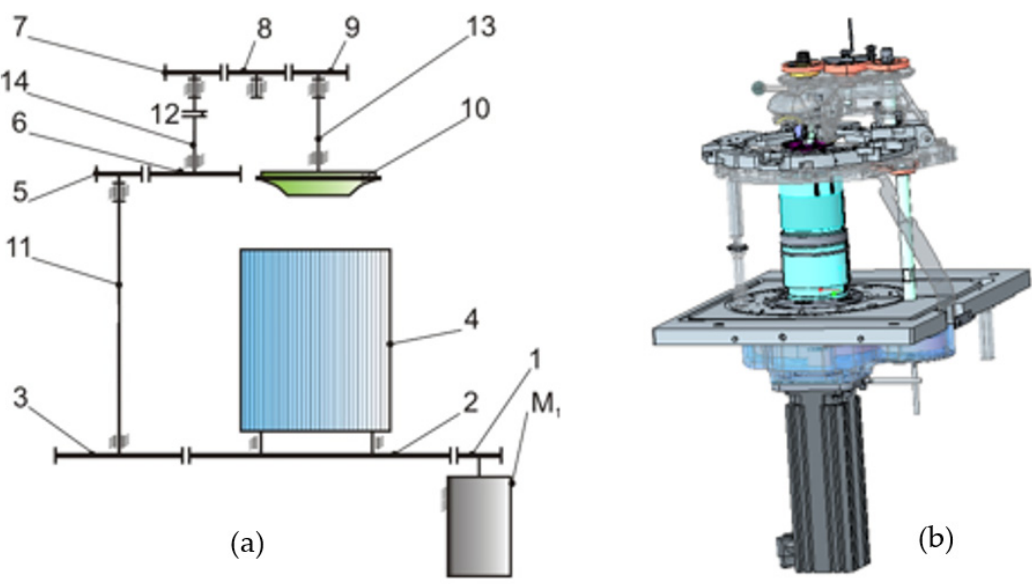
Figure 2. Structure of the present concept of the small diameter knitting machine: ( a ) schematic view ( b ) 3D model.